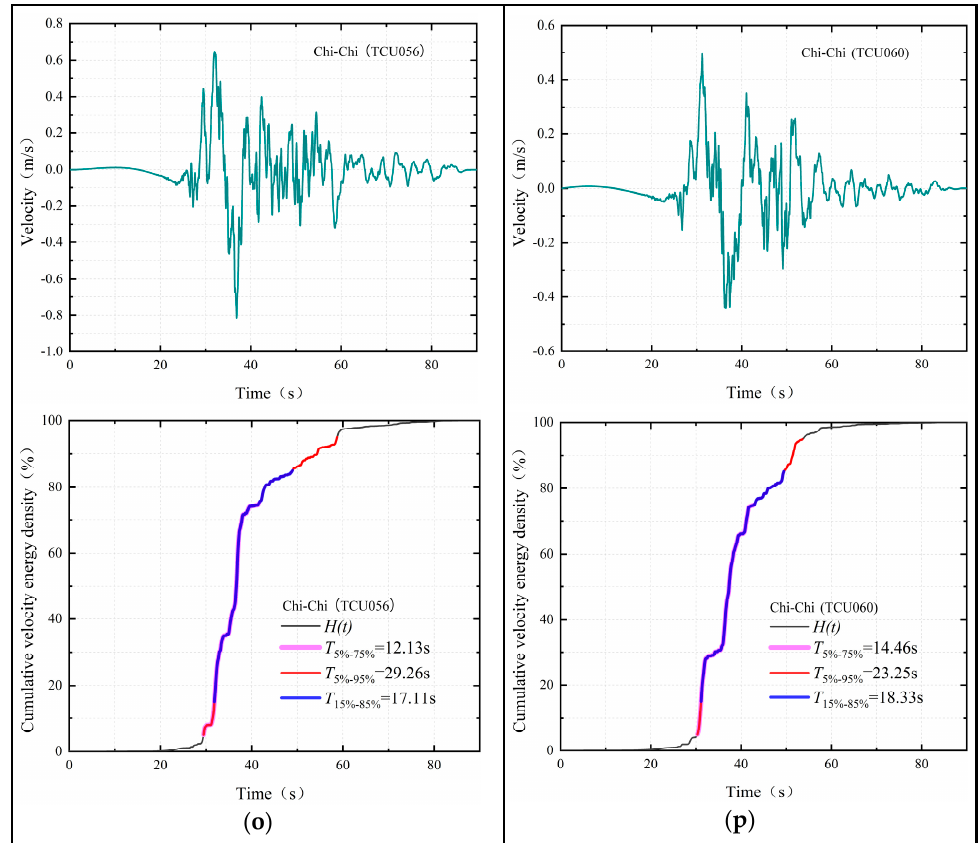
Figure 2. The velocity time-histories and the with the corresponding EVD. ( a ) San Fernando, ( b ) Coyote Lake, ( c ) Imperial Valley-06 (Aeropuerto Mexicali), ( d ) Imperial Valley-06 (Brawley Airport), ( e ) Imperial Valley-06 (El Centro Array #11), ( f ) Imperial Valley-06 (El Centro Array #3), ( g ) Imperial Valley-06 (El Centro Differential Array), ( h ) Mendocino, ( i ) Landers (Barstow), ( j ) Landers (Yermo Fire Station), ( k ) Northridge-01, ( l ) Kocaeli, ( m ) Chi-Chi (TCU053), ( n ) Chi-Chi (TCU054), ( o ) Chi-Chi (TCU056), ( p ) Chi-Chi (TCU060).